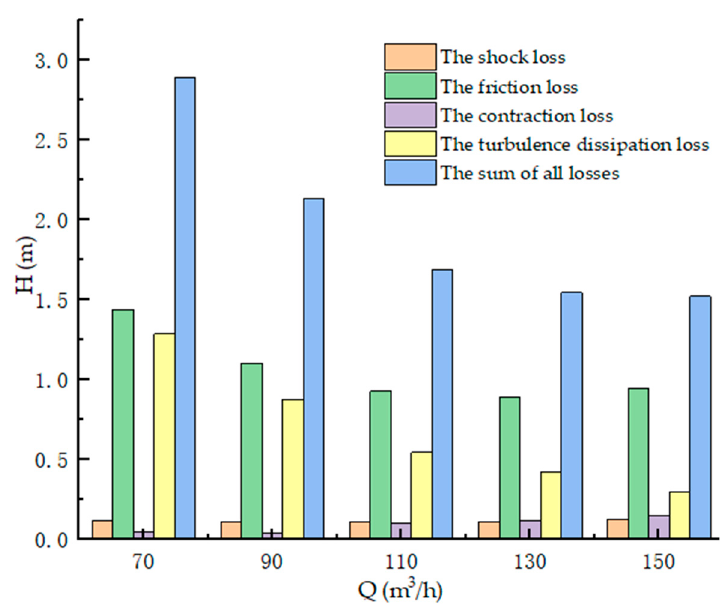
Figure 18. The energy losses of the static impeller at different flow rate.